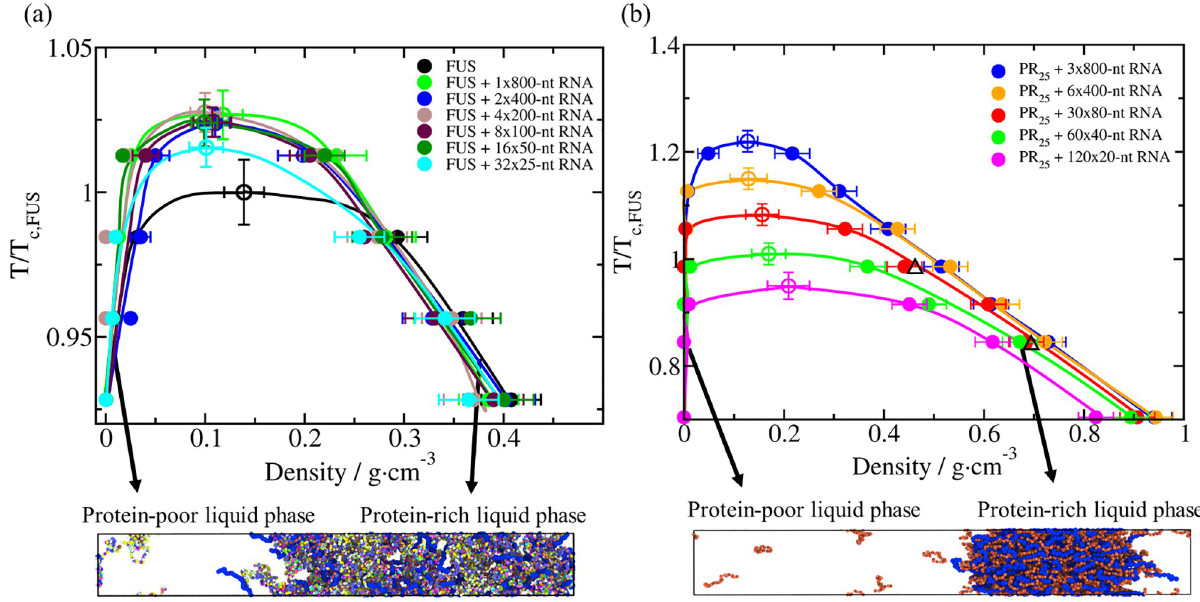
Fig 3. (a) Temperature–density phase diagrams of FUS with polyU RNA of different lengths at a constant polyU/FUS mass ratio of 0.096, and for a pure system of FUS (black curve). The length of polyU RNA strands range from 25-nucleotide to 800-nucleotide. (b) Temperature–density phase diagrams of PR 25 with RNA at different lengths at a constant RNA/PR 25 mass ratio of 1.20. RNA lengths range from 20-nucleotide to 800-nucleotide strands. To verify that our simulations are not affected by finite size effects, we repeated our simulations with 60 chains of 80-nt each (instead of 30 polyU chains), while keeping the RNA/PR 25 mass ratio constant, and computed the coexistence densities (black empty triangles). In both (a) and (b) panels, filled circles represent the coexisting densities evaluated from DC simulations while empty circles depict the critical temperatures estimated from the law of rectilinear diameters and critical exponents [119] near the critical temperature. The error bars in the coexistence densities represent standard deviations, while those of the critical points represent the extrapolated uncertainty when applying the law of rectilinear diameters and critical exponents. Temperature in both panels has been normalized by the critical temperature of pure FUS, T c , FUS = 355 K (black empty circle in (a)). Representative snapshots of the DC simulations used to compute the phase diagrams of both systems for a given RNA strand length (a) FUS–polyU (2x400-nt) and b) PR 25 –polyU (6x400-nt)) under phase-separating conditions are included below. The same color code employed in Fig 1 applies here.